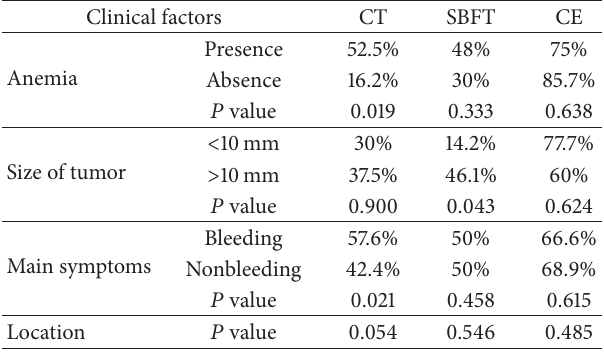
Table 3: Comparison of diagnostic yields of capsule endoscopy and other radiologic studies.